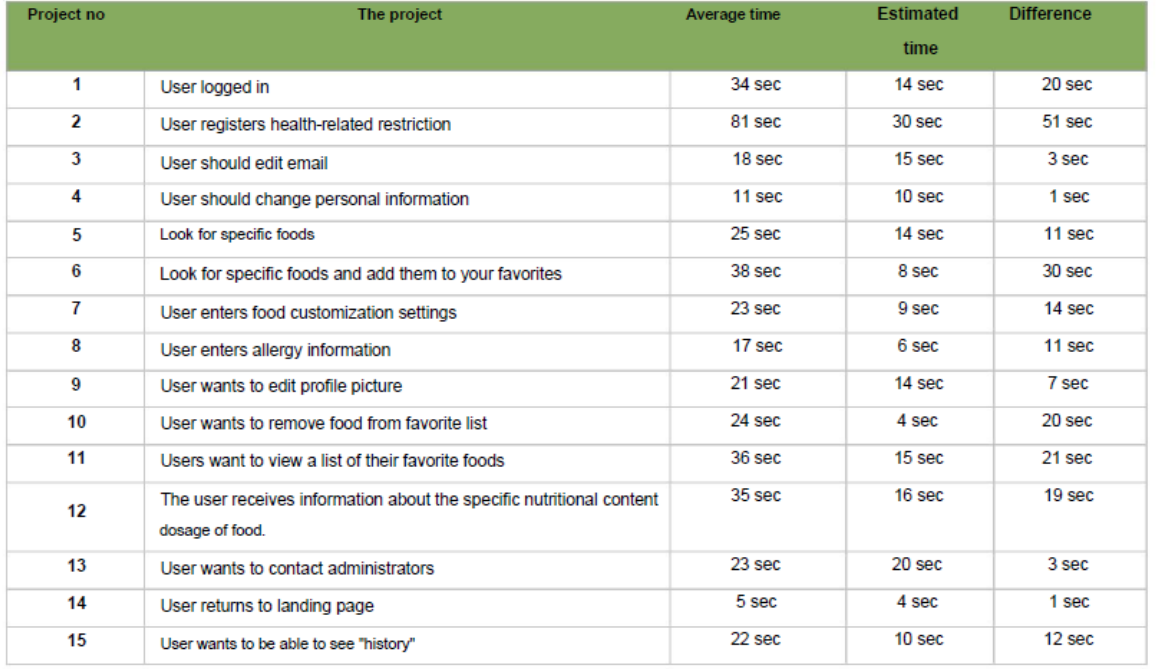
Table 2. Summary of user test